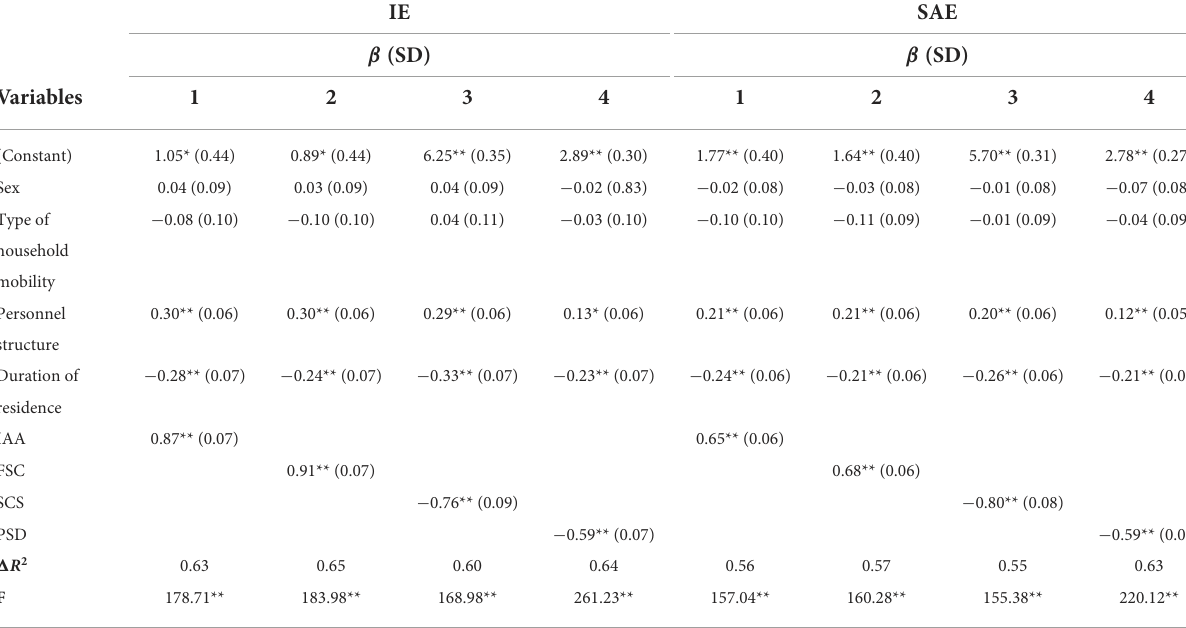
TABLE 4 Regressions results of the effect of demographic and related variables, IAA, FSC, SCS, and PSD on IE and SAE.